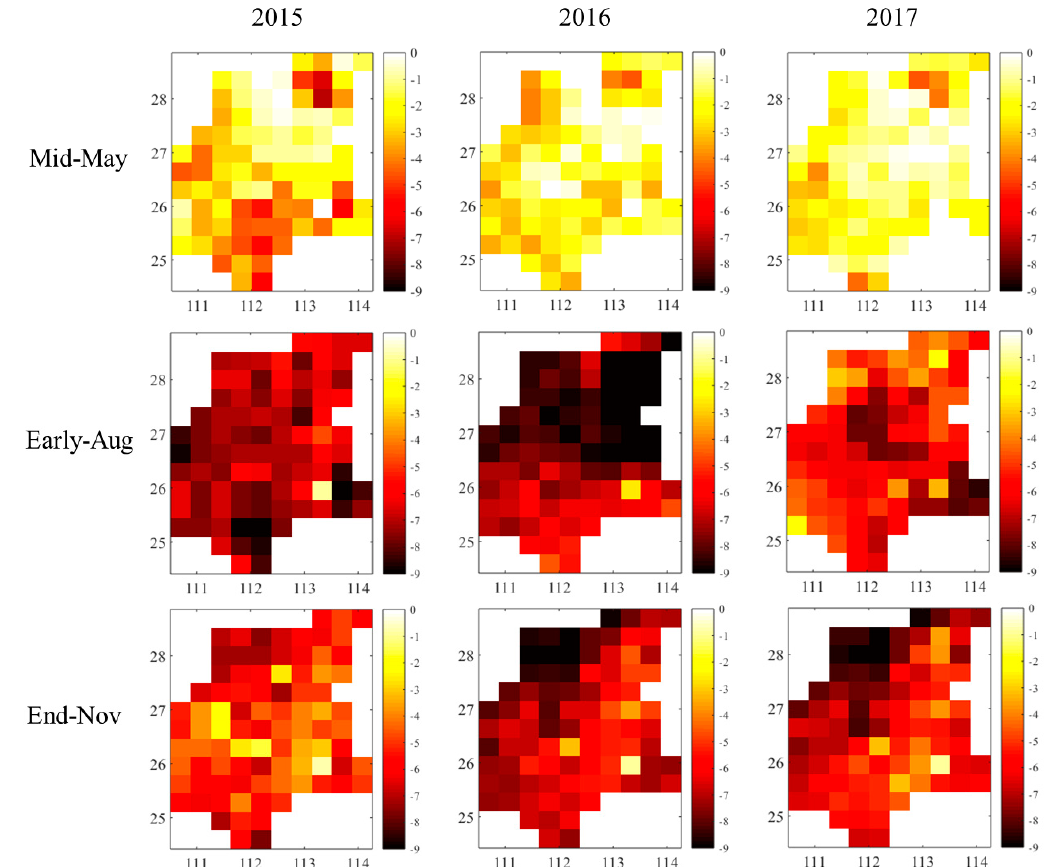
Figure 6. Spatial distribution of SMAP_SWDI during mid-May, early August, and at the end of November in the Xiang River Basin from 2015 to 2017.